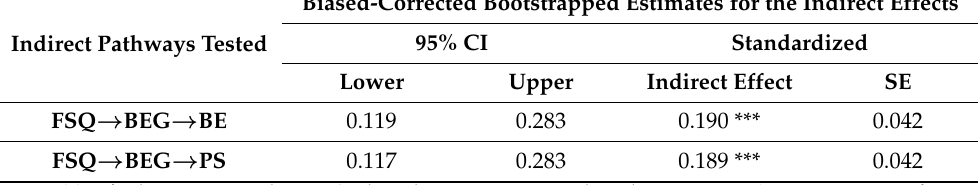
Table 4. Mediation analysis with bootstrap.